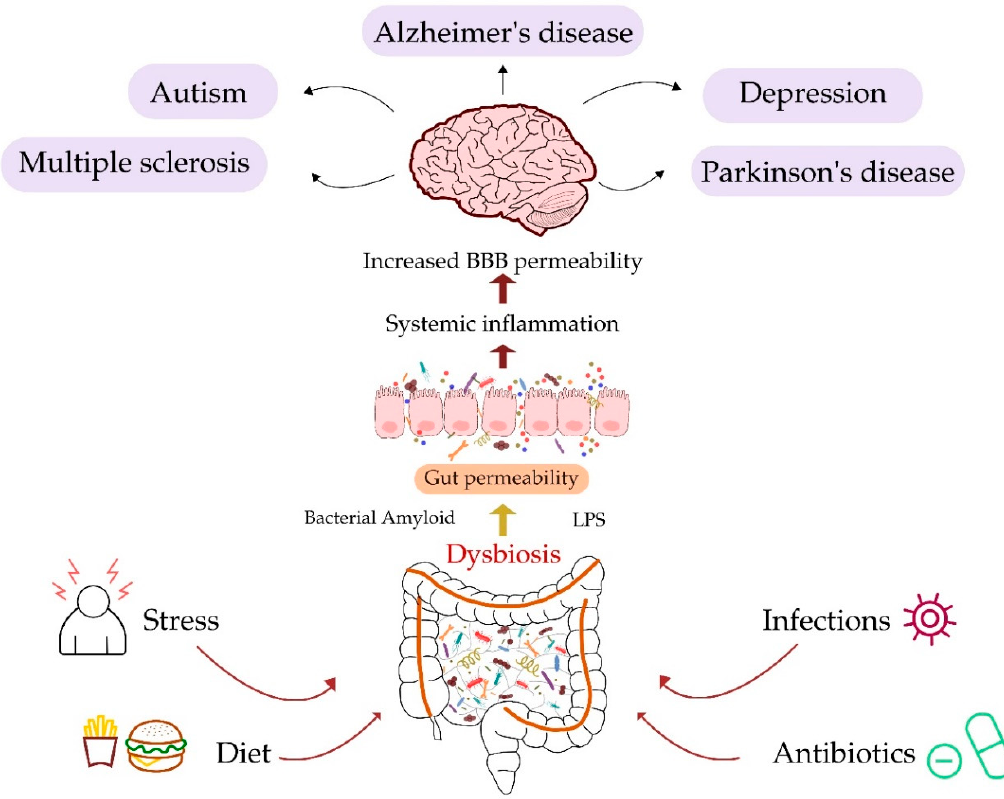
Figure 2. Schematic description of disturbances in the intestinal microbiota and diseases of the CNS. The figure depicts major factors, such as stress [29], diet [21], infections, and antibiotic intake [28], which can promote dysbiosis in the gut microbiota. Changes in the composition of the microbiome lead to gut permeability, influencing systemic inflammation and, as a result, may induce diseases of the CNS .